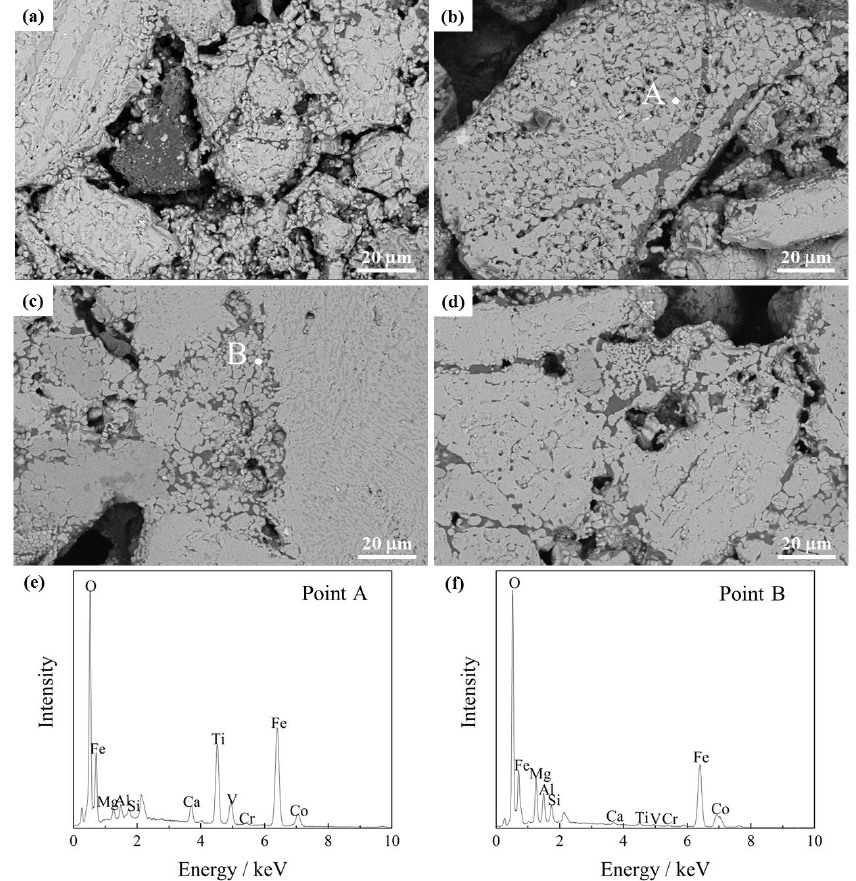
Figure 8. SEM-EDS analysis of CVTP with Co 2 O 3 additions: ( a ) 0 wt %, ( b ) 2 wt %, ( c ) 4 wt %, ( d ) 6 wt %, ( e ) Point A, and ( f ) Point B.